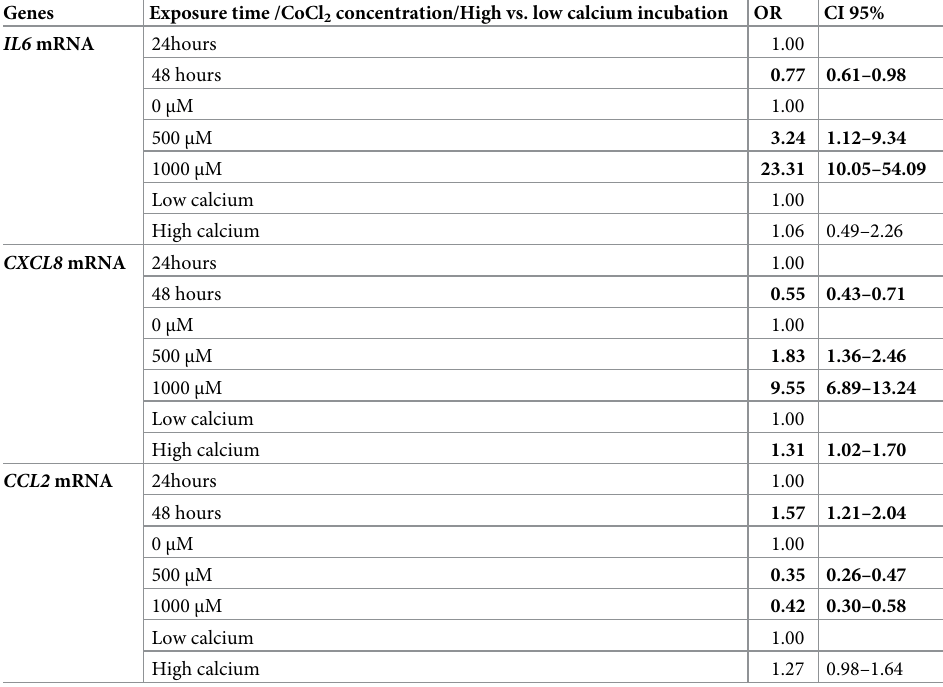
Table 4. Linear regression mixed model analyses showing dose- and time-relationships for IL6 mRNA, CXCL8 mRNA and CCL2